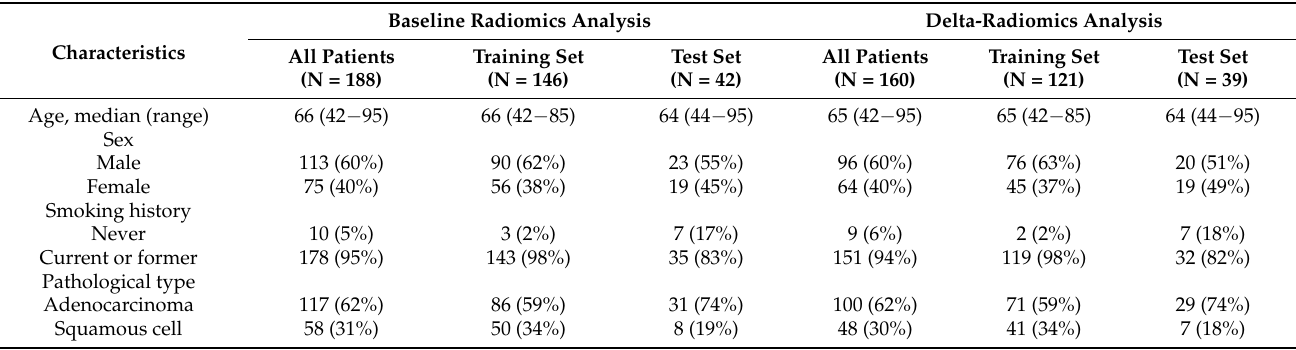
Table 1. Demographic and clinical characteristics of